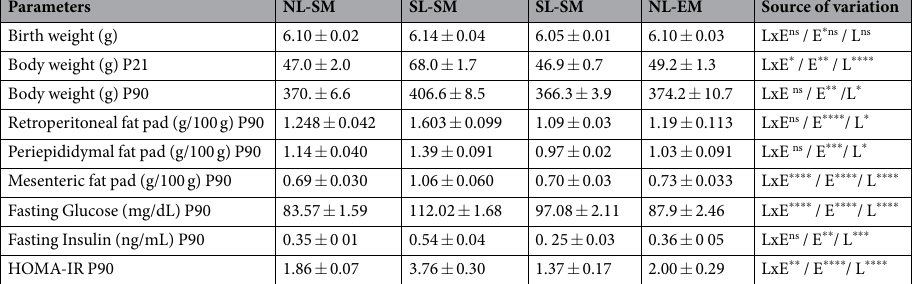
Table 3. Effect of low intensity physical exercise training on metabolism and fat pad stores in offspring rats. Data are expressed as the mean ± SEM (n = 6–18) at P0, P21 and P90. LxE, interaction between the exercise factor and the litter factor; E, exercise factor and L, litter factor; * p < 0.05, ** p < 0.01, *** p < 0.001, **** p < 0.0001 and ns, no significant difference, based on a two-way analysis of